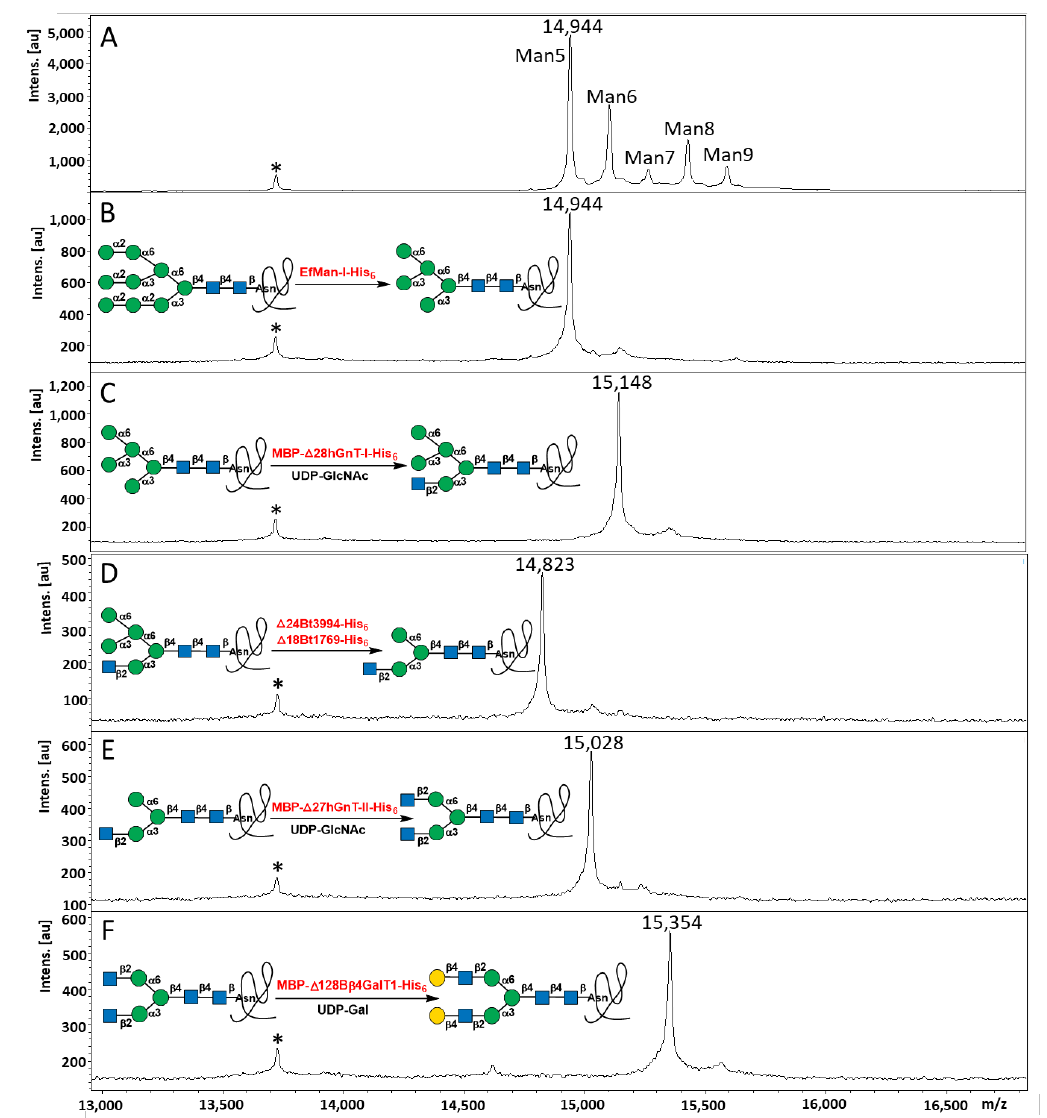
Figure 3. MALDI-TOF MS analysis results for RNase B with heterogeneous high-mannose N-glycans ( A ) and RNase B sequentially treated with EfMan-I-His 6 ( B ), MBP- ∆28hGnT -I-His 6 ( C ), ∆24Bt3994 -His 6 and ∆18Bt1769 -His 6 ( D ), MBP- ∆27hGnT -II-His 6 ( E ), and MBP- ∆128Bβ4GalT1 -His 6 ( F ) in step-wise reactions. The peak marked with an asterisk (*) in each figure is for RNase A, the non-glycosylated ribonuclease that is present in the commercially obtained RNase B sample, which was used as the internal standard. The schematic illustrations of the corresponding reactions are shown. The number above each peak represents the m / z value of the expected product + 2Na species.